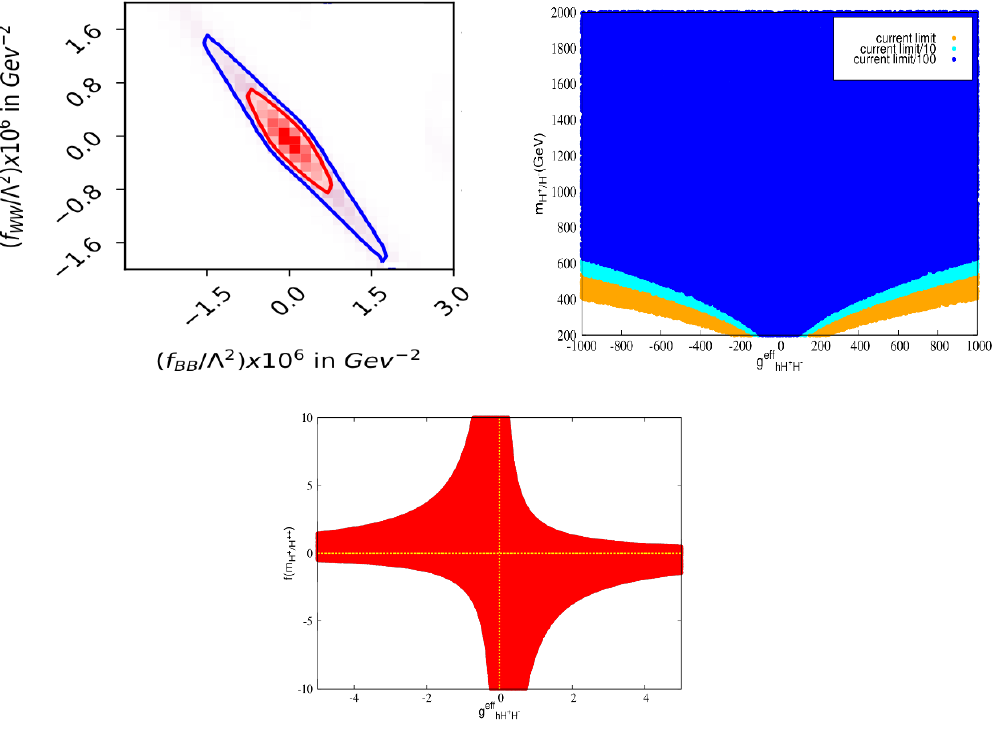
Figure 17 . Allowed regions at 1 (cid:27) (red) and 2 (cid:27) (blue) levels in the parameter space of scale factors and dimension-6 couplings in the triplet scenario.